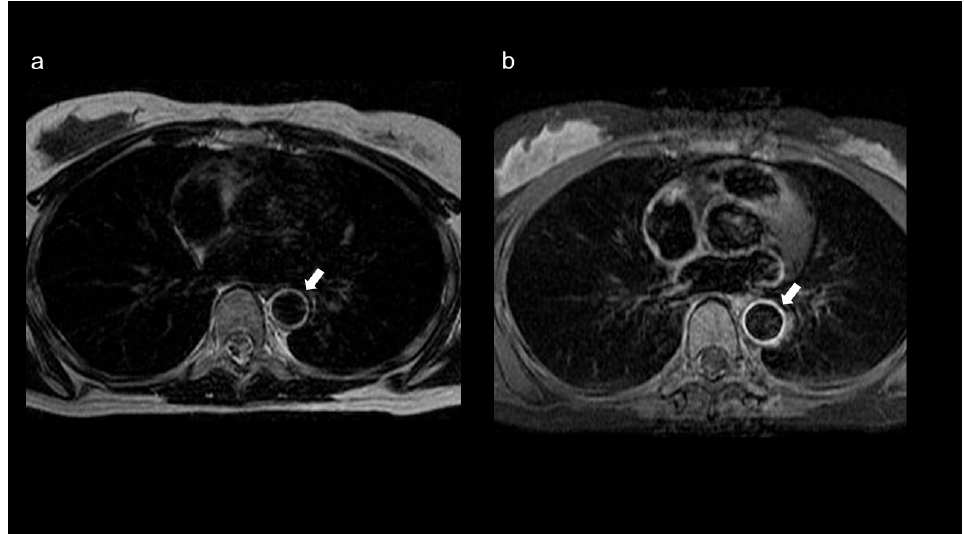
Figure 2. MRI of an 18-year-old female patient with TA. ( a ) The T2-weighted image shows a ring-shaped high signal along the intima in the aortic wall (arrow), and ( b ) the contrast-enhanced T1-weighted image shows a contrast effect in the aortic wall (arrow).